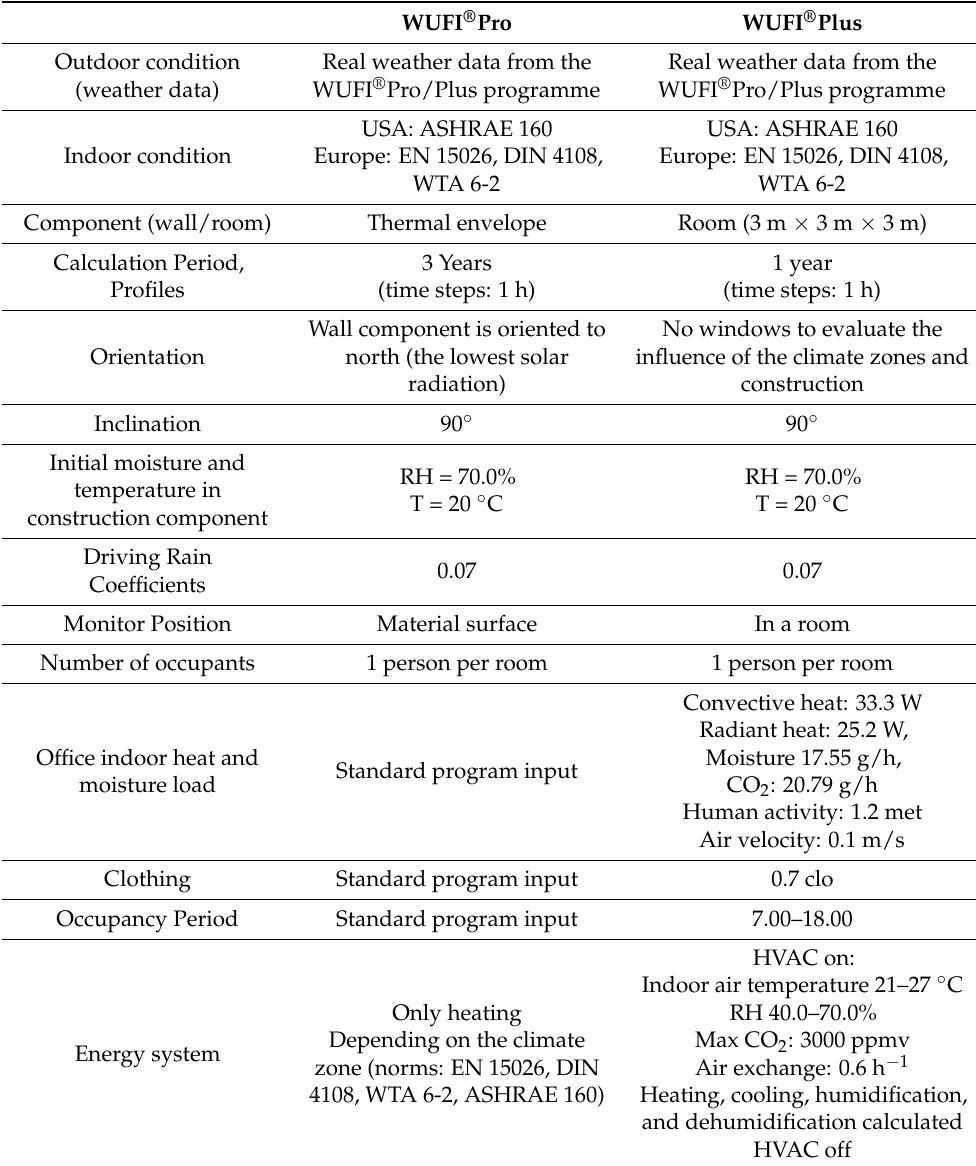
Table 2. Outdoor and indoor conditions for the simulation